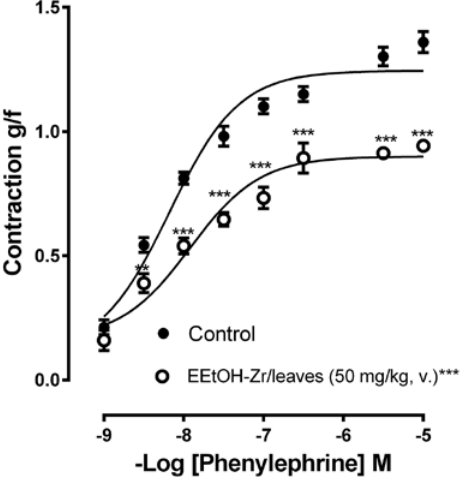
FIGURE 4 - Vascular Reactivity of EEtOH-Zr/sheets (50 mg/kg/ 7 days) on contractions induced by cumulative addition of phenylephrine (10 -9 -10 -5 M) in absence of the mesenteric vascular endothelium. Values were expressed as mean ± s.e.m. (●) control; (○) EEtOH-Zr (50 mg/kg/7 days); ** p<0.05, *** p<0.001 vs . control, n=12 rings.